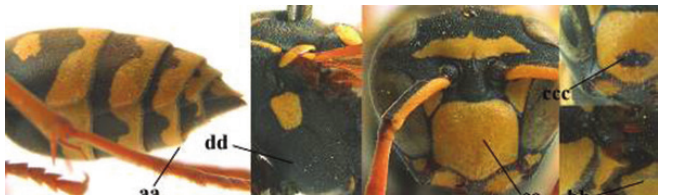
– Apical yellow band of sternite IV usually complete and wide (aa); hind coxa with yellow patch dorsally (bb); central dark patch on clypeus usually less developed and situated below middle of clypeus (ccc) or absent (cc); usually with an abrupt change in sculpture between mesepisternum and epicnemium (dd; = epicnemial ridge distinct), but sometimes rather gradual ................ 20